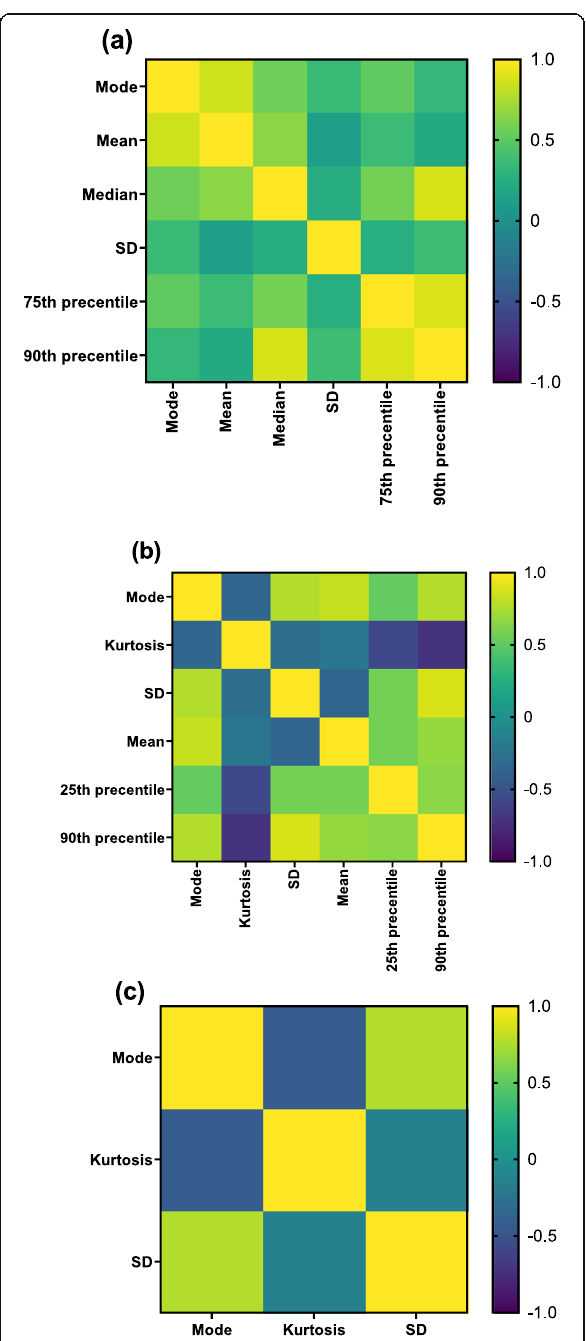
Fig. 3 The correlation coefficient matrix heat map of ADC ( A ), post- contrast T1WI ( B ), and T2WI-FLAIR ( C ) volumetric histogram parameters of meningioma tumors obtained from the data of all patients (without considering the tumor